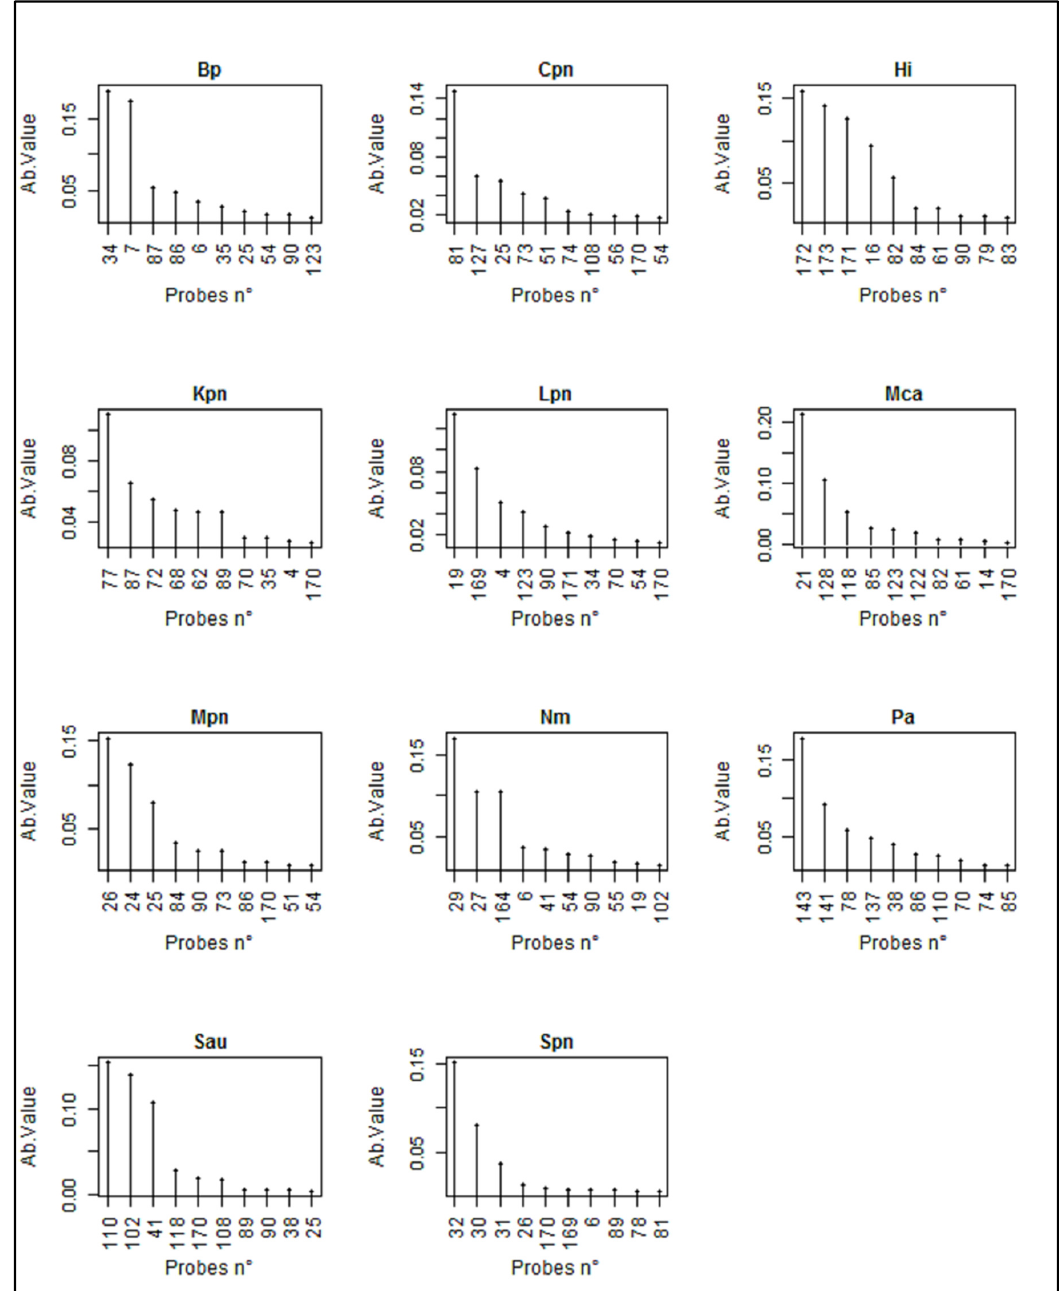
Figure 4. Probes patterns for the 11 pathogen bacteria obtained by random forests statistical